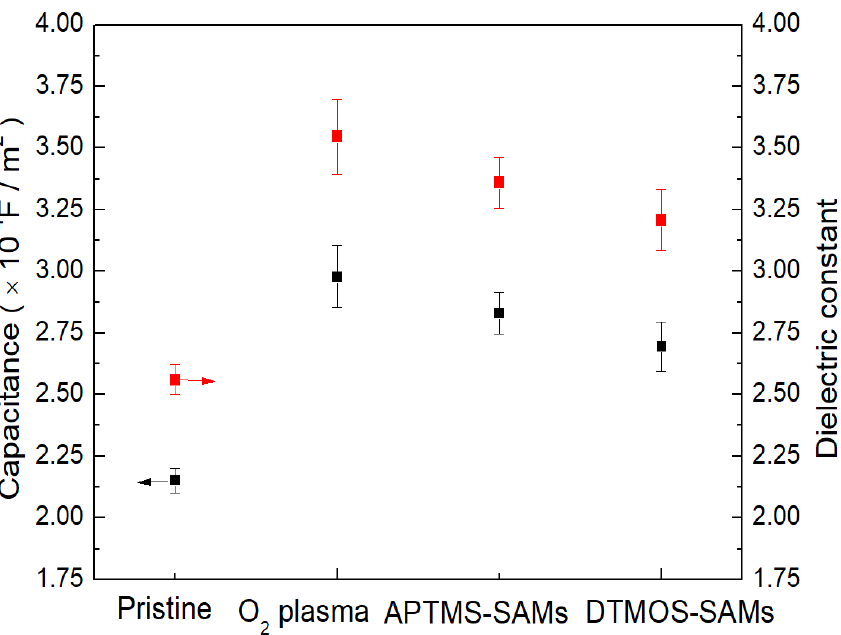
Figure 2. Comparison of accumulation capacitance and dielectric constant of pristine, O 2 plas- ma-irradiated, APTMS-SAMs, and DTMOS-SAMs p-SiOCH films. irradiated, APTMS-SAMs, and DTMOS-SAMs p-SiOCH